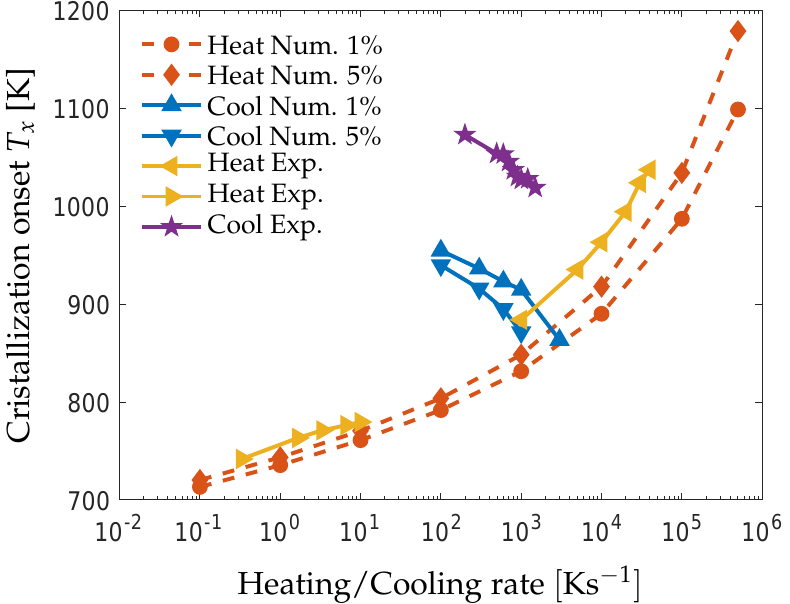
Figure 5. Numerically obtained crystallization temperatures of the CuZr 2 phase from a matrix composition of Al 10 Cu 30 Zr 60 during continuous heating (red) and cooling (dark blue) rates. Experimentally measured onset temperatures upon heating (yellow) and cooling(purple) [ ? ? ].